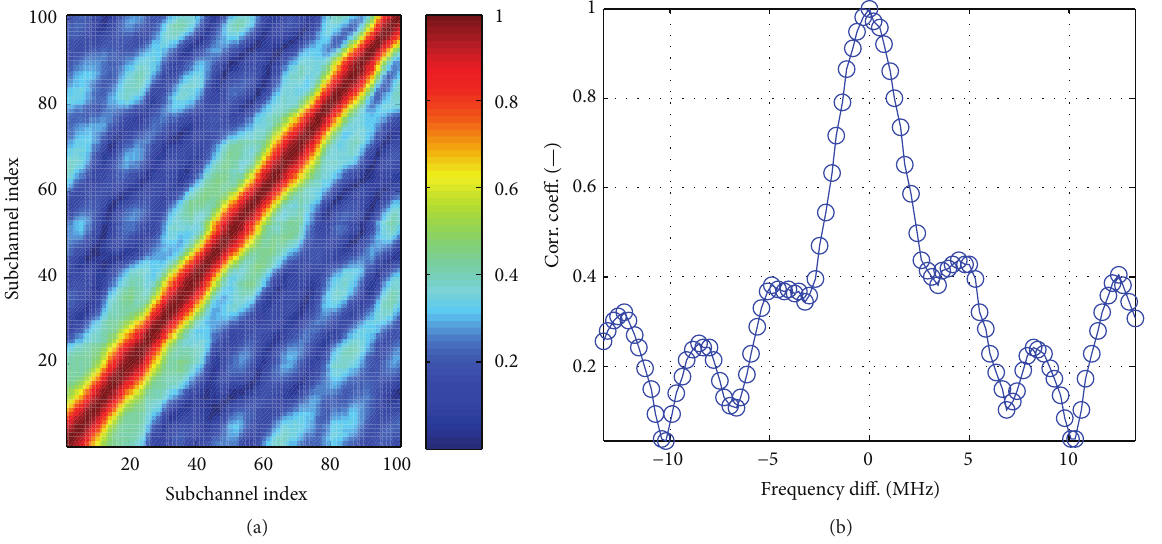
Figure 4: Cross-correlation between subchannels for other measurement data (a) and cross-correlation between middle subchannel and the other subchannels